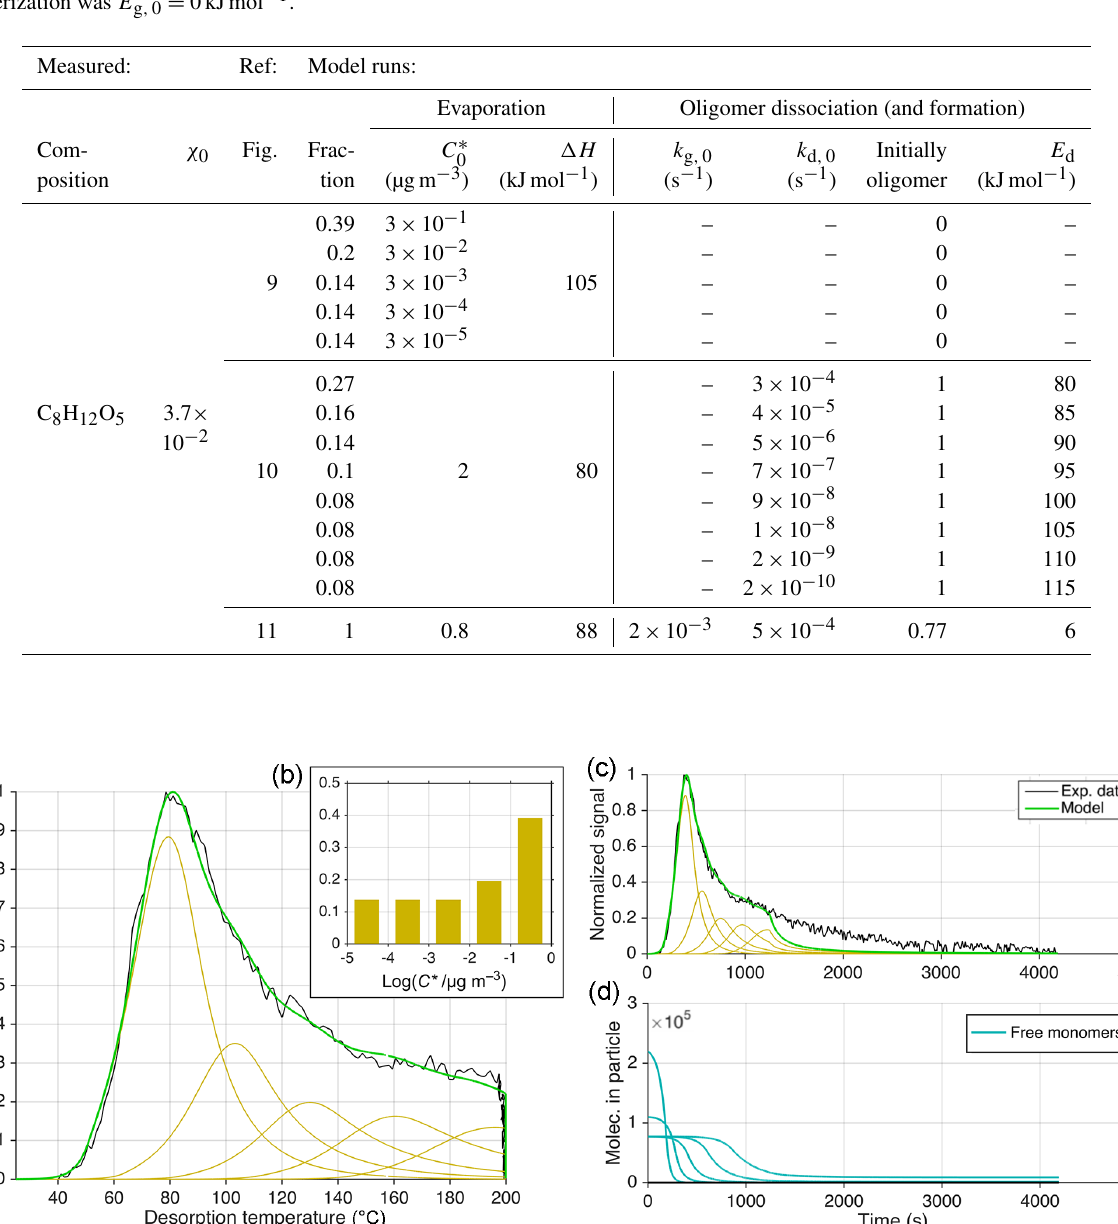
Figure 9. Illustration of approach 1 (out of three) for reproducing the thermogram observed for composition C 8 H 12 O 5 during desorption of SOA generated from dark α -pinene ozonolysis. This approach is based on excluding oligomerization but using five logarithmically spaced (b) . (a) is the classical normalized thermogram, i.e., in temperature space. Experimental data are shown in black, and model data in beige for the individual bins and in green for their sum. (c) presents the thermogram vs. time ( t ), which is identical to (a) up to t = 1250s, because temperature was ramped linearly with time to 200 ◦ C, but reveals a failure in reproducing the soak period (constant 200 ◦ C for t> 1250s). In (d) , the number of molecules still in the particle phase is plotted vs. time, one line for each VBS